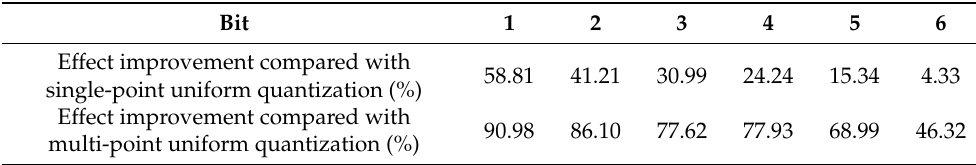
Table 4. The improvement in PRD by non-uniform quantization.